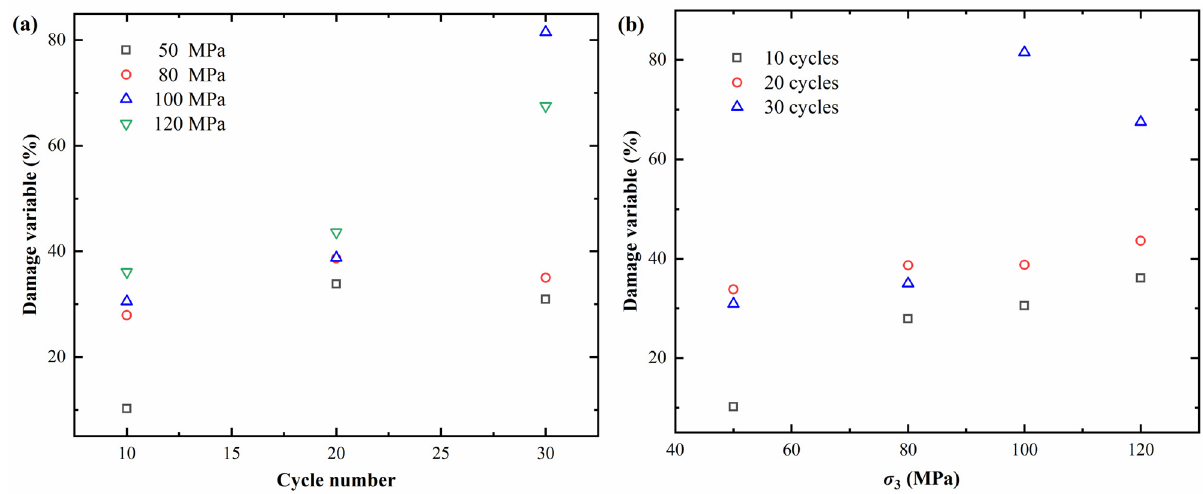
Figure 8. Damage variables of pre-damaged specimens. ( a ) Relationship between D and cycle numbers; ( b ) relationship between D and σ 3